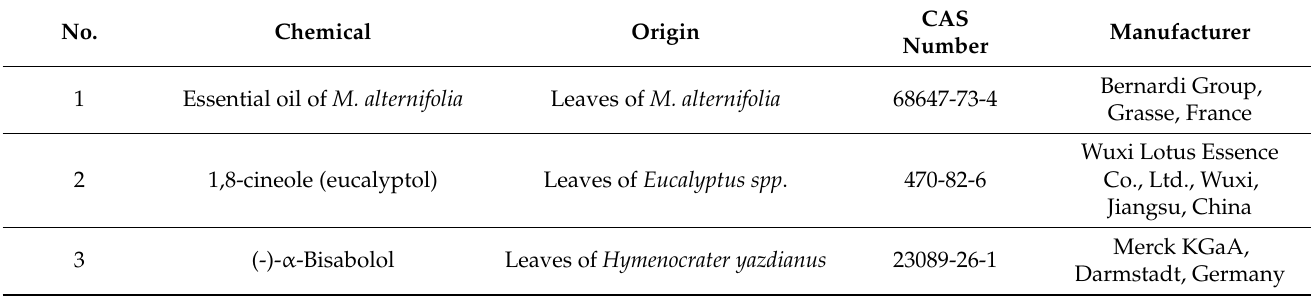
Table 7. Components of the tested plant-based